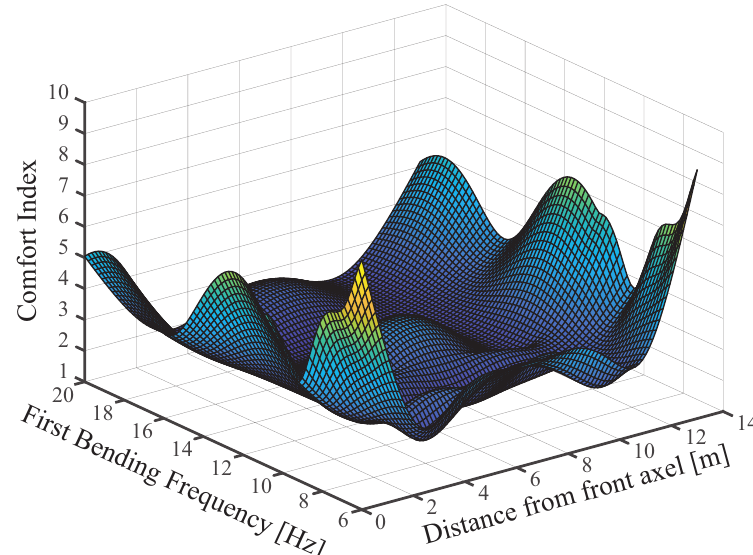
Figure 7. Comfort index along the length of the beam versus the first bending frequency ( f 3 ).